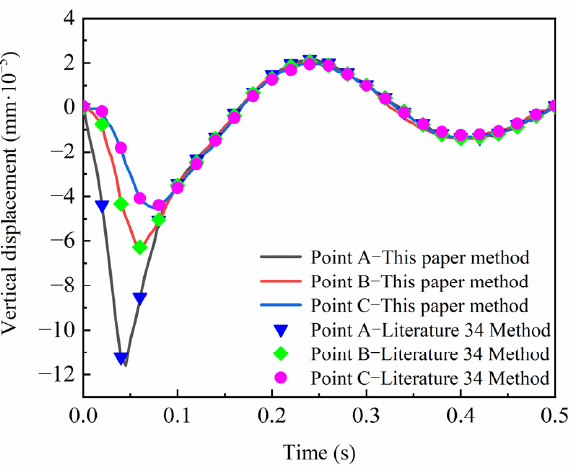
Figure 8. The vertical displacement–time curve of the observation point.